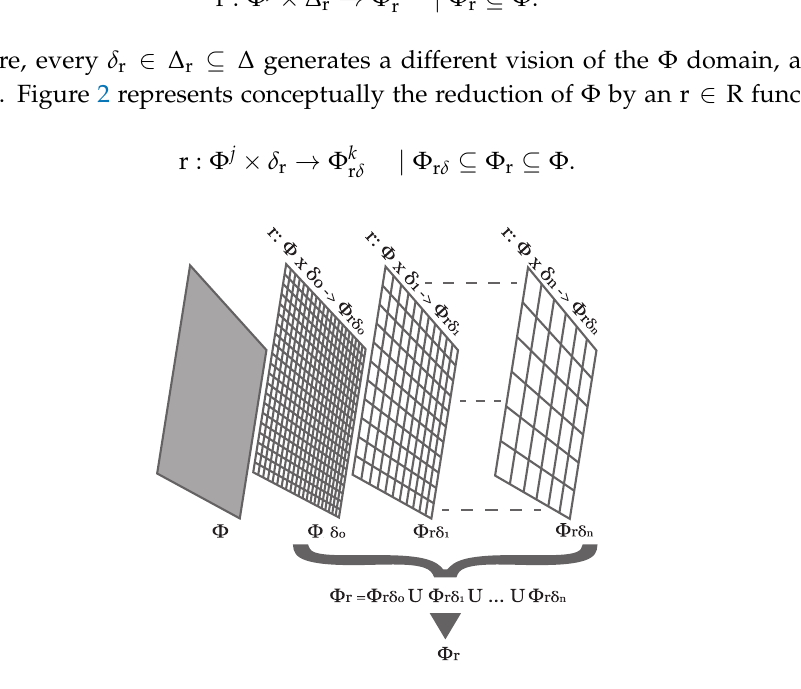
Figure 2. Φ domain reduced to a set of Φ r δ domains ( j = k =